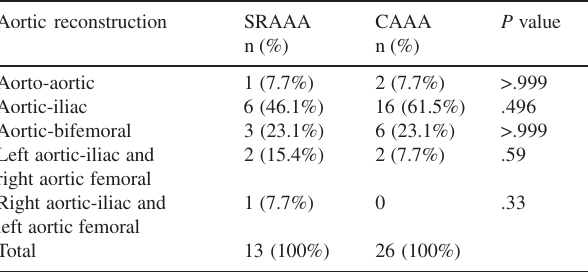
Table 3 - Aortic reconstruction technique in 13 patients with SRAAA and 26 controls (CAAA). Fischer’s exact